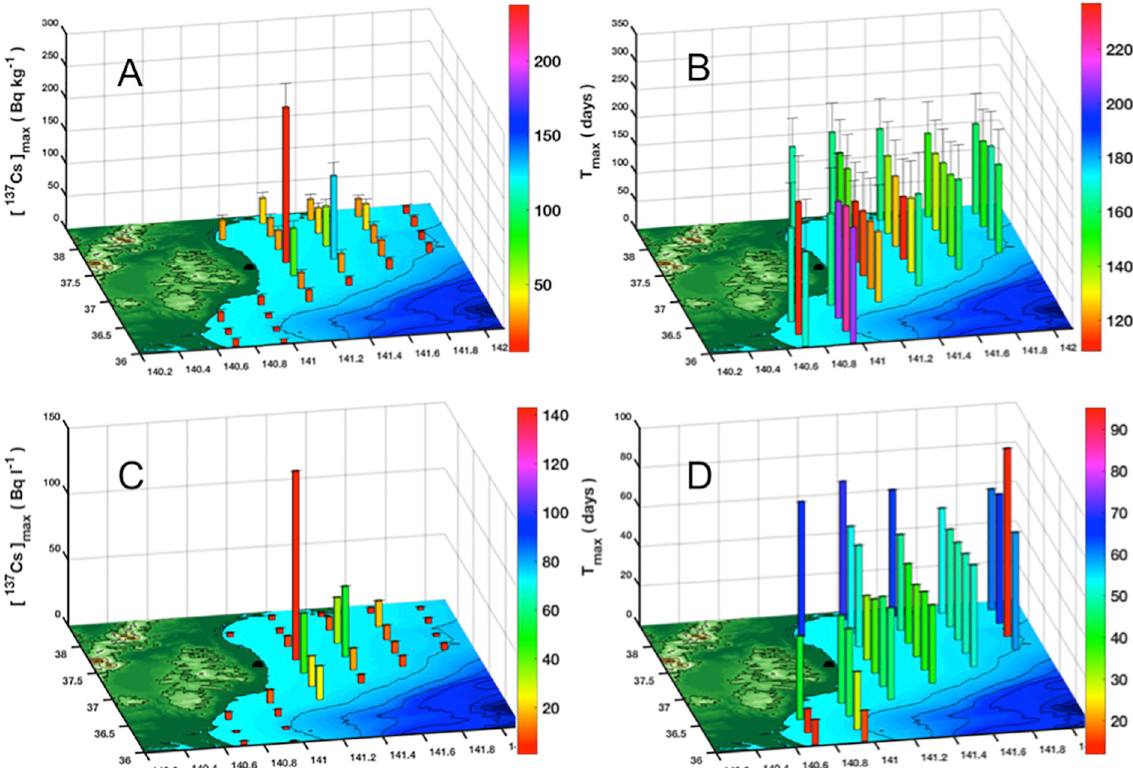
Fig 11. Spatial distribution of: (A) the maximum 137 Cs activity concentration in the organism (Bq kg -1 ), (B) its corresponding T max (in days), (C) the maximum 137 Cs activity concentration in seawater (in Bq l -1 ), (D) the T max corresponding to the maximum concentration in seawater (in days). The values shown in this Figure are calculated over the cohorts related to all the studied species.